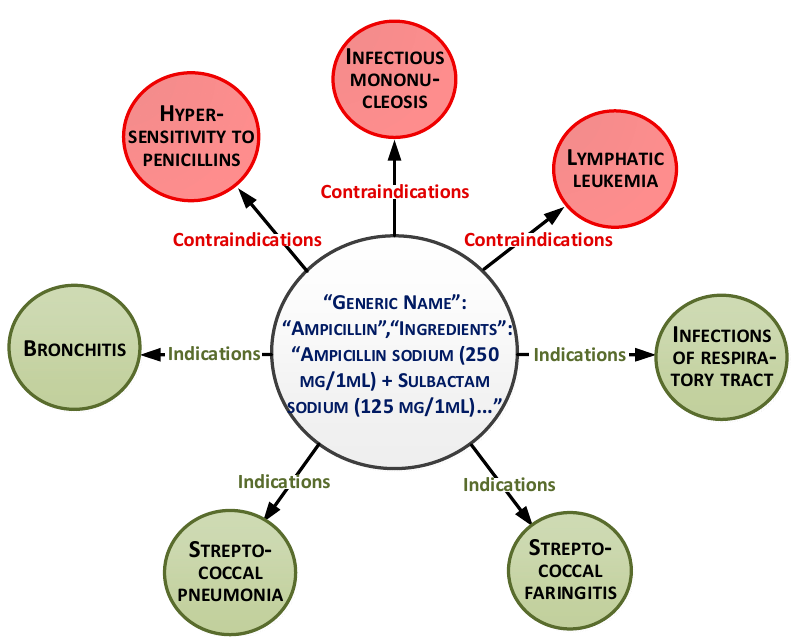
Figure 1. An example of a document-oriented graph.